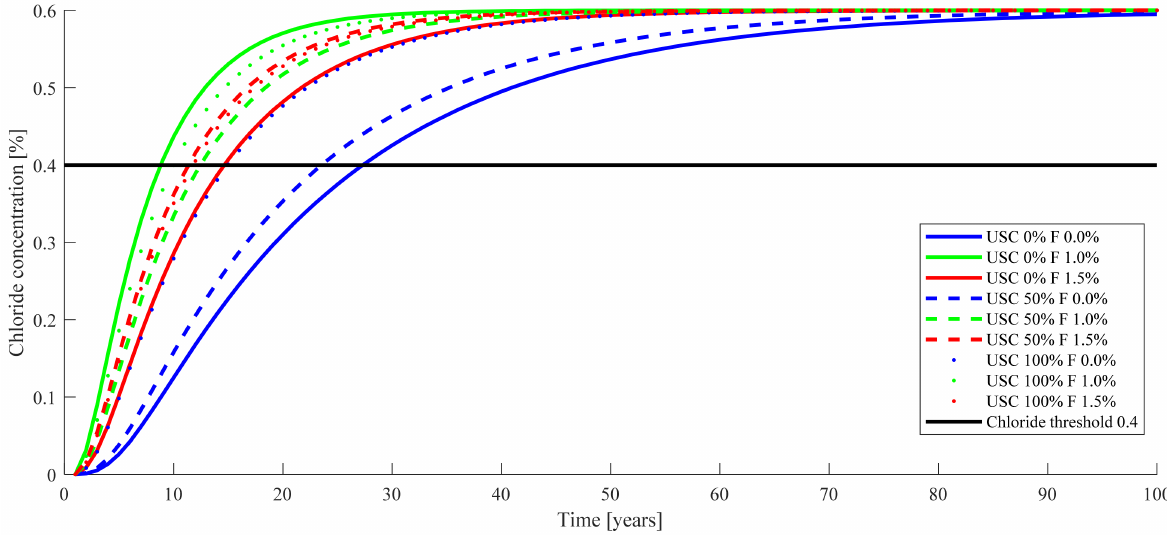
Figure 4. Chloride concentration over time regarding the constant diffusion